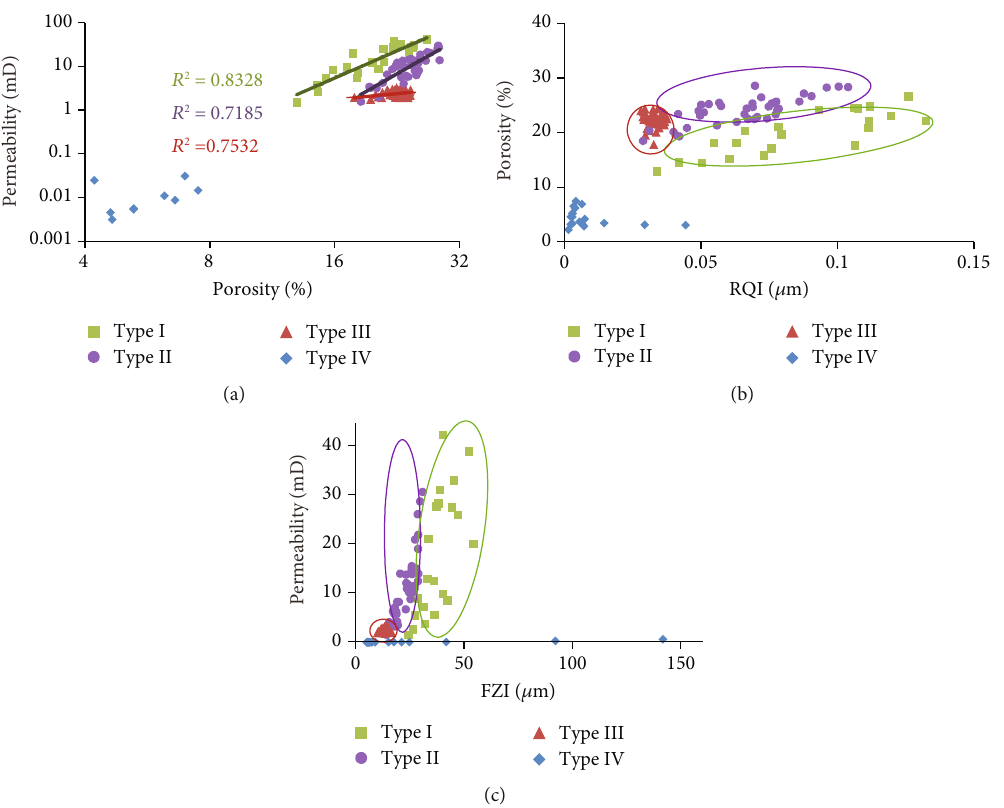
Figure 11: (a) Plot shows that porosity and permeability distribution of di ff erent pore structure types has obvious zoning. (b) Plot shows that RQI and porosity distribution of di ff erent pore structures has obvious zoning. (c) Plot shows that FZI and permeability distribution of di ff erent pore structures has obvious